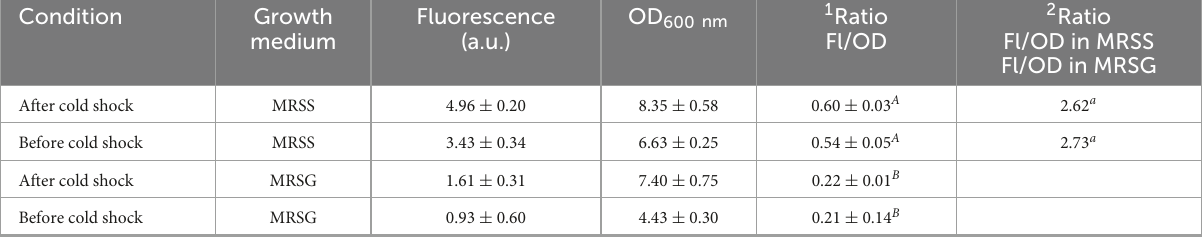
TABLE 1 Analysis of fluorescence and growth of Lc. lactis AV1n[pRCR21] before and after 10 ◦ C cold shock.